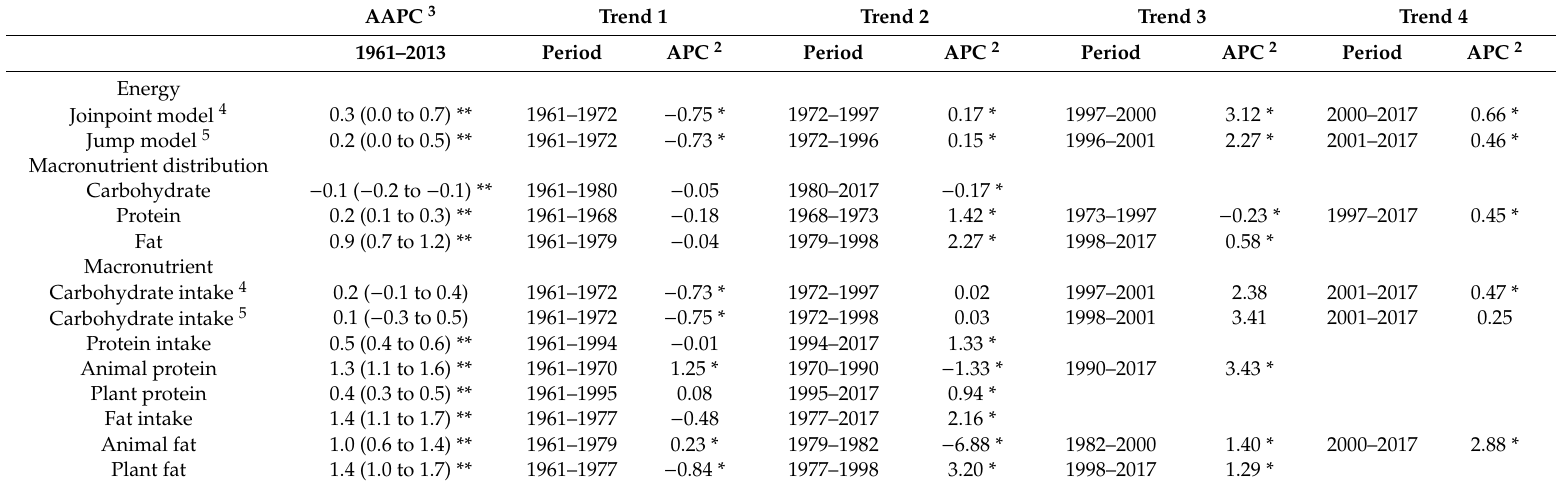
Table 2. Trends in apparent energy and macronutrient intakes in the diet in Bangladesh from 1961 to 2017 1